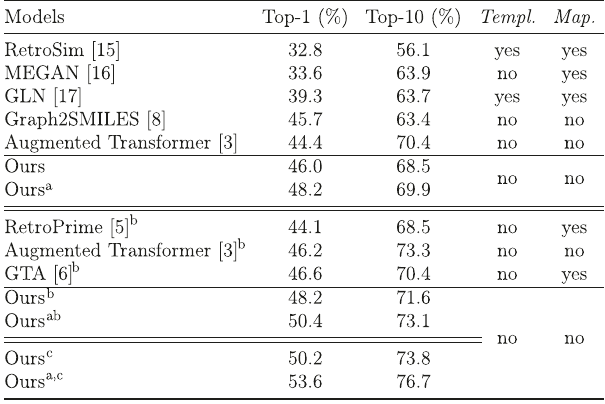
Table 1 | The results of retrosynthesis on USPTO_full